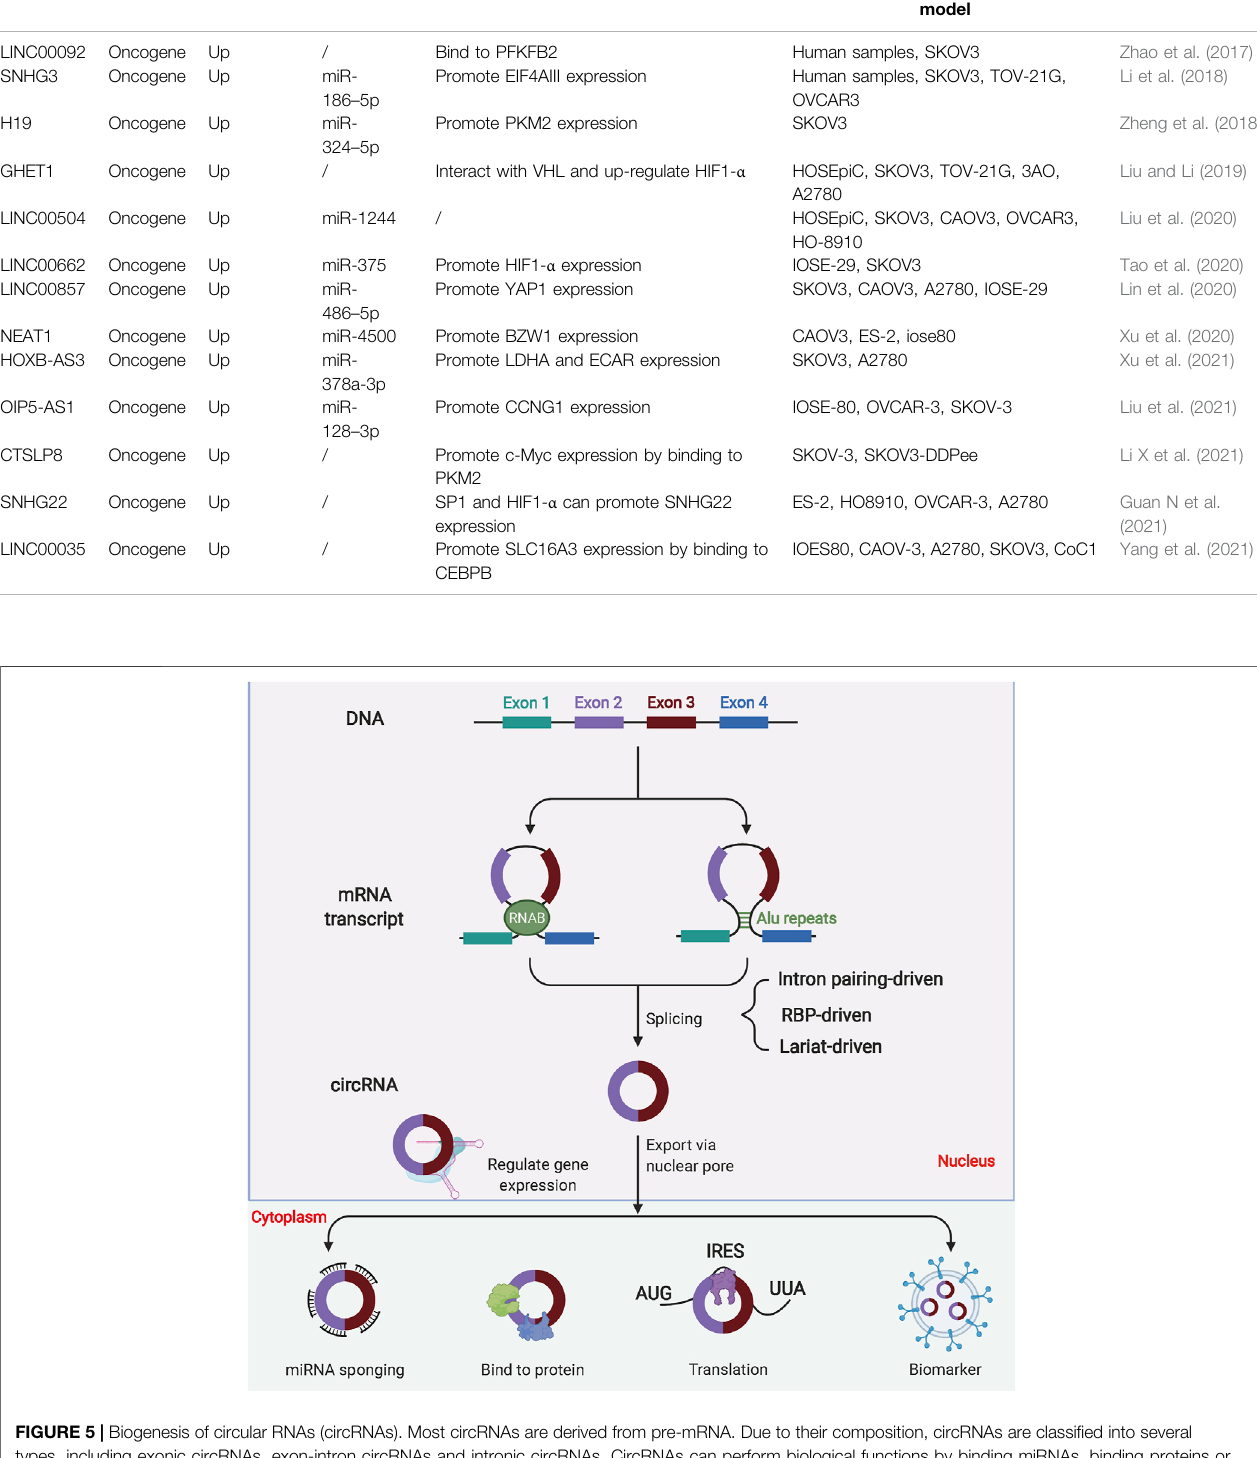
Frontiers in Pharmacology |